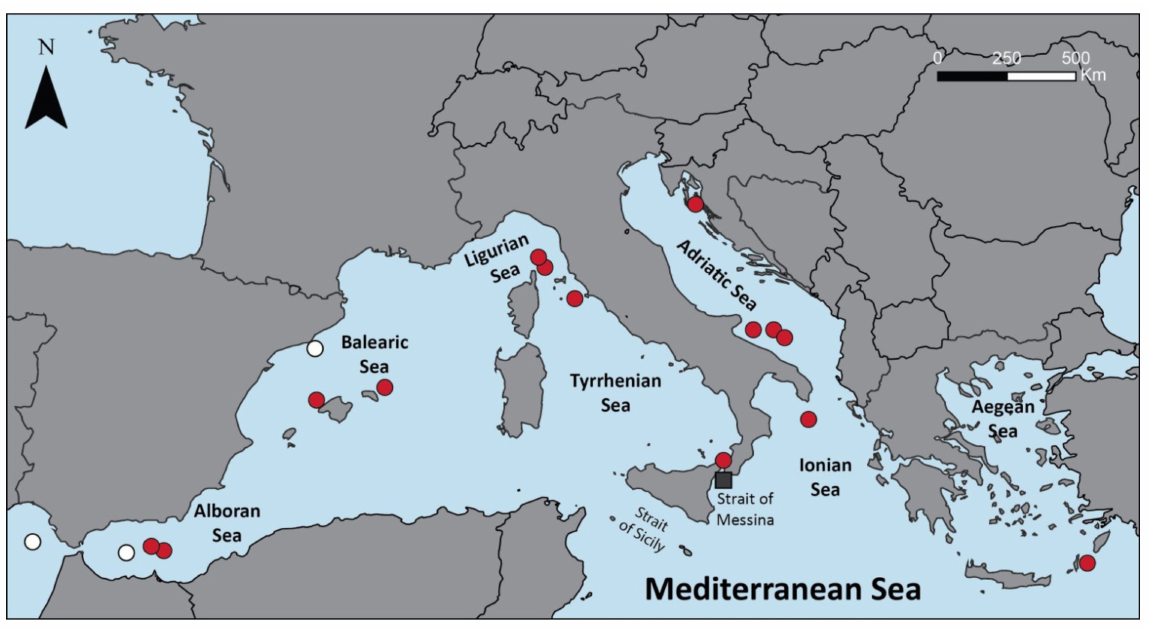
Figure 1. Distribution of Draculamya uraniae n. sp. Square: type locality; red circles: this study; white circles: litera- ture